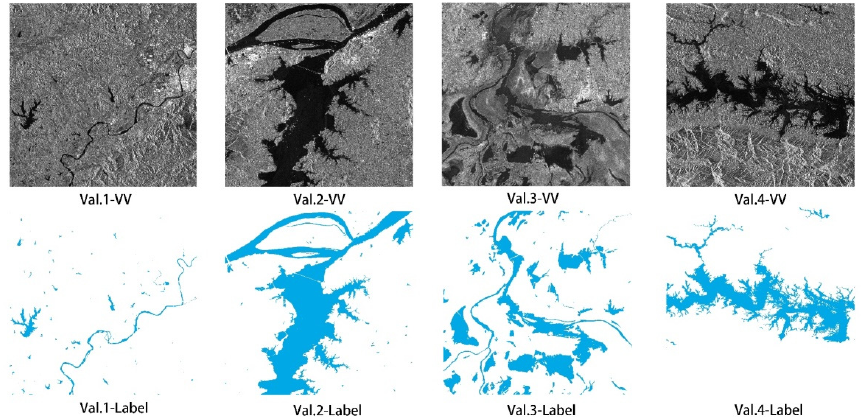
Figure 11. Four validation samples (VV polarization) and corresponding ground truth labels. Val. 1 is the small mountain river. Val. 2 is the plain lake surface in the wet season. Val. 3 is the plain lake surface in the dry season. Val. 4 is the mountain branch